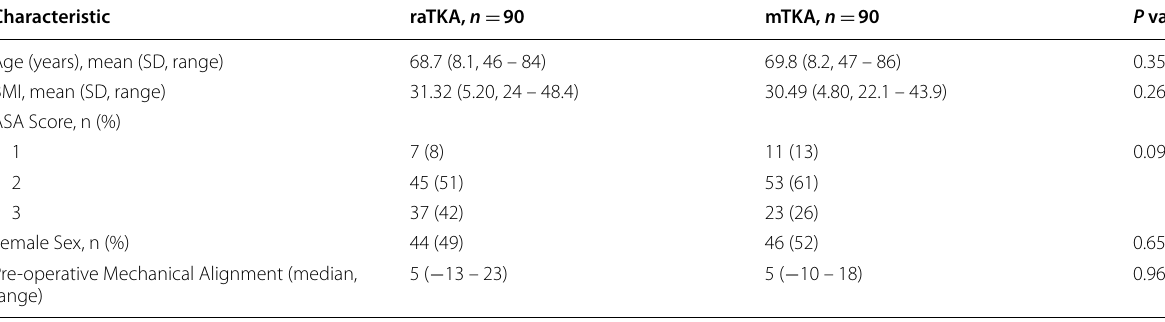
BMI body mass index (kg/m 2 )